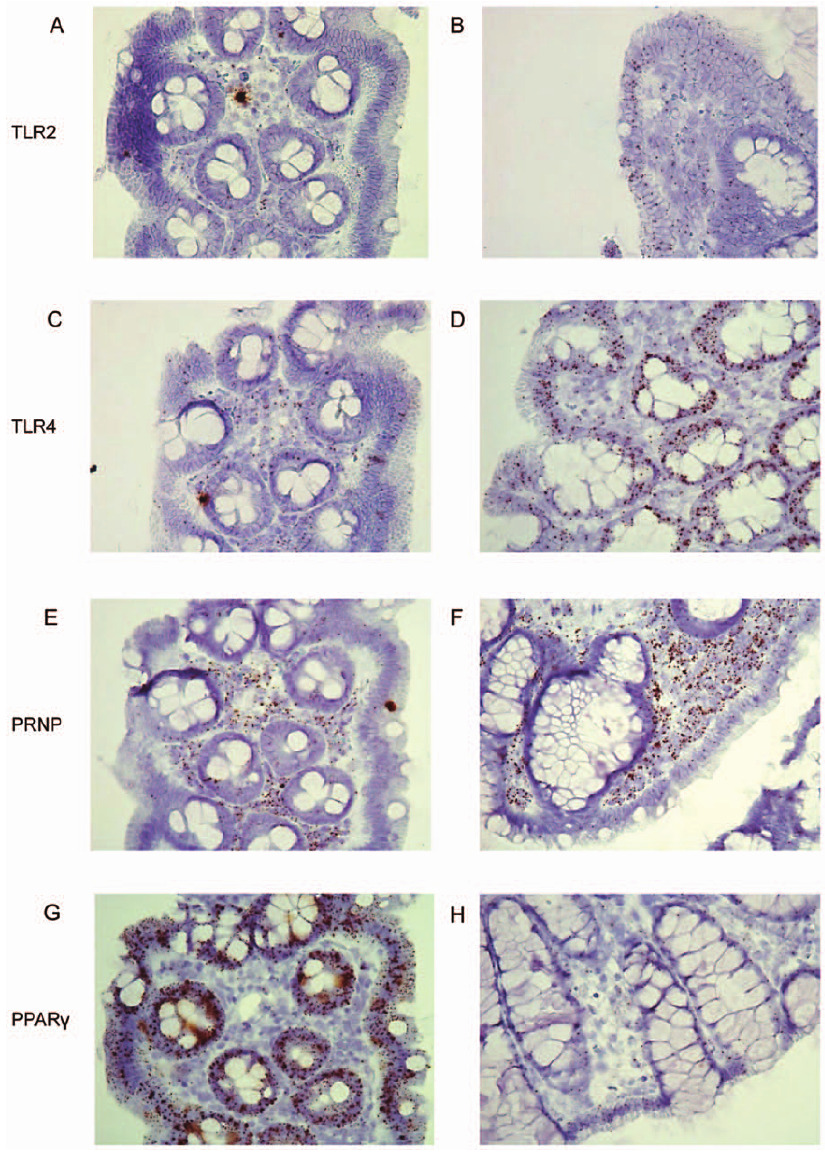
Figure 8. Insitu hybridization (ISH) of significantly regulated genes in TNBS colitis mucosal biopsies. (A and C) The expression of TLR2 and TLR4 is scattered in the epithelium and submucosal immune cells at T0. (B and D) Increased TLR2 and TLR4 expression was noted in the epithelium at T7. (E) PRNP expression in submucosal immune cells at T0. (F) Intense PRNP expressing cells were evident in the submucosa at T12 and also to some degree in the epithelium. (G) Intense clusters of PPAR c expression in epithelial cells at T0. (H) At T12, the expression is almost abolished. Objective x40 in all pictures. doi:10.1371/journal.pone.0054543.g008 such as Apoptosis , Cell junction organization , Interleukin-1 processing ; non- In situ hybridization (ISH) of target genes in TNBS-colitis concordant pathways included GABA-A receptor activation , Extrinsic Markers of mucosal inflammation and selected microarray pathways for apoptosis and Recycling of bile acids and salts . Similarly, the targets were analyzed using ISH. These included inflammatory most concordance was noted between UC and T3 (KEGG: cytokines (IL-1 a and IL-1 b ) and TLRs (TLR2 and TLR4), as well rho= 0.52, p= 6 6 10 2 15 , Reactome: rho= 0.45, p= 0) (Figure 7). as the computationally identified genes PPAR c and PRNP. For example, concordant Reactome pathways included Nuclear An overall increase in gene expression of IL-1 a and IL-1 b was receptor transcription pathway , TNF signaling , and VEGF ligand-receptor evident in submucosal inflammatory infiltrates at T3-T12. interactions , while non-concordant Reactome pathways included However, changes in expression varied with the degree of Apoptotic execution phase and TRAIL signaling . The full list of regulated inflammation in individual animals. Colitis induction resulted in pathways in TNBS and IBD is accessible through supplementary increased expression of TLR2 and TLR4 in epithelial cells Table S3. (Figure 8A, B, C and D). PRNP expression was increased both in submucosal inflammatory cells and to some degree also in